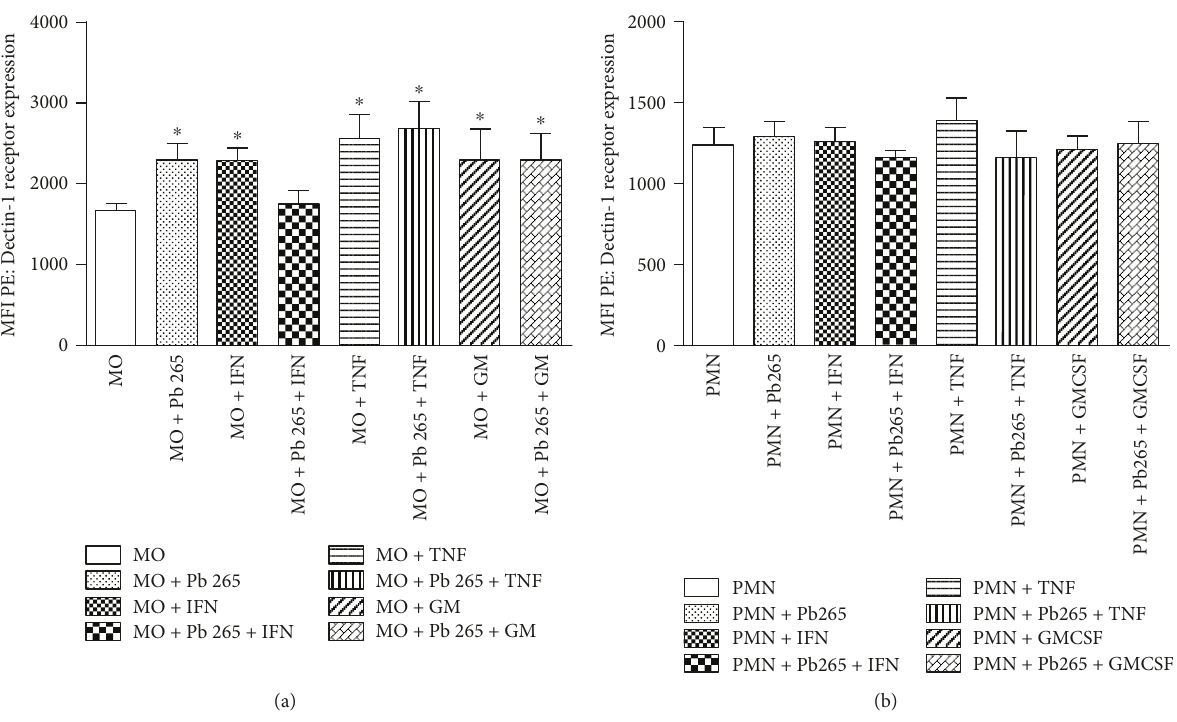
Figure 1: Dectin-1 receptor expression (MFI) of monocytes (MO) (a) and neutrophils (PMN) (b) treated or not with IFN- γ , TNF- α , and GM-CSF for 18 hours followed by the Pb265 challenge or not for 4 hours. Data are expressed as the mean of 8 healthy volunteer donors tested. ∗ Statistical signi fi cance between groups is indicated ( ∗ p < 0 05× MO